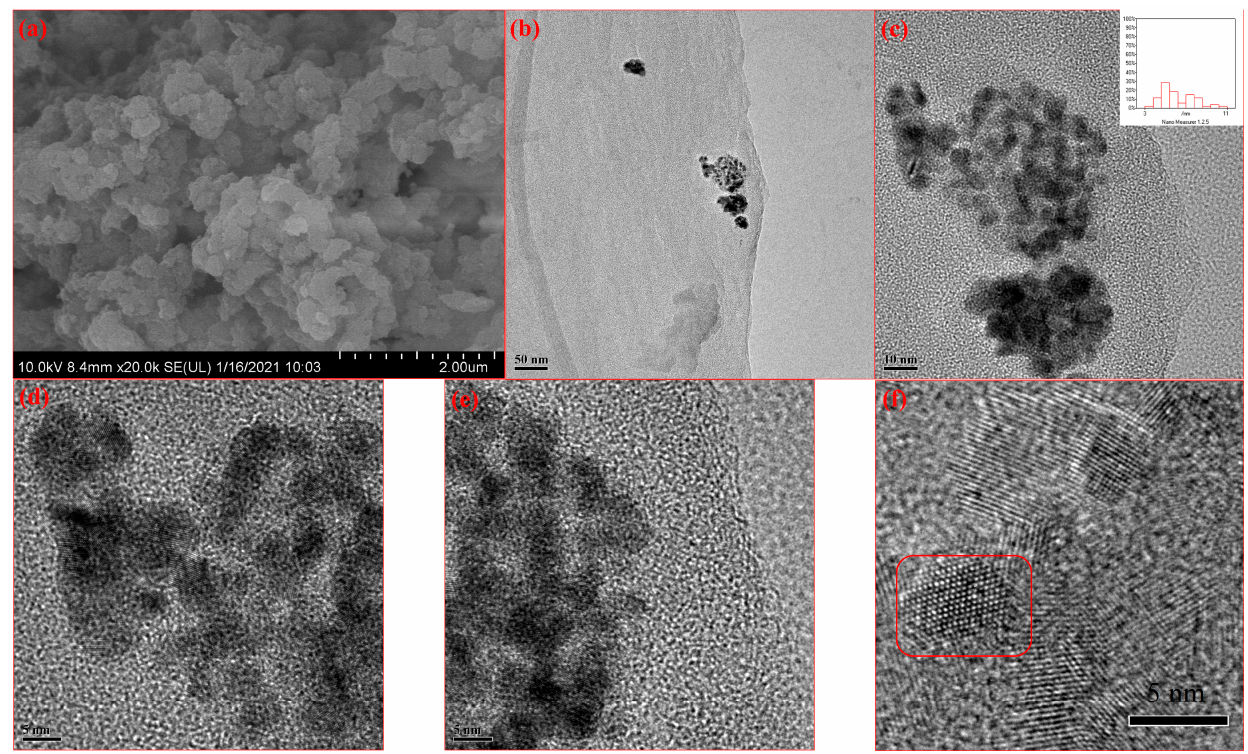
Figure 2. SEM and TEM characterizations of AEPOP and Pd@AEPOP. ( a ) SEM image of AEPOP, ( b – e ) Pd NPs in different scales, ( f ) diffraction fringe of